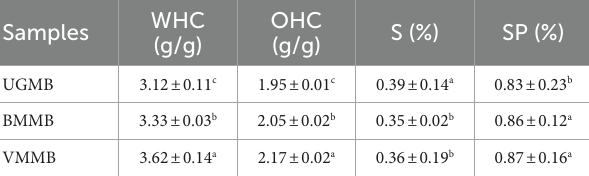
TABLE 2 Water holding capacity, oil holding capacity, solubility and swelling power.